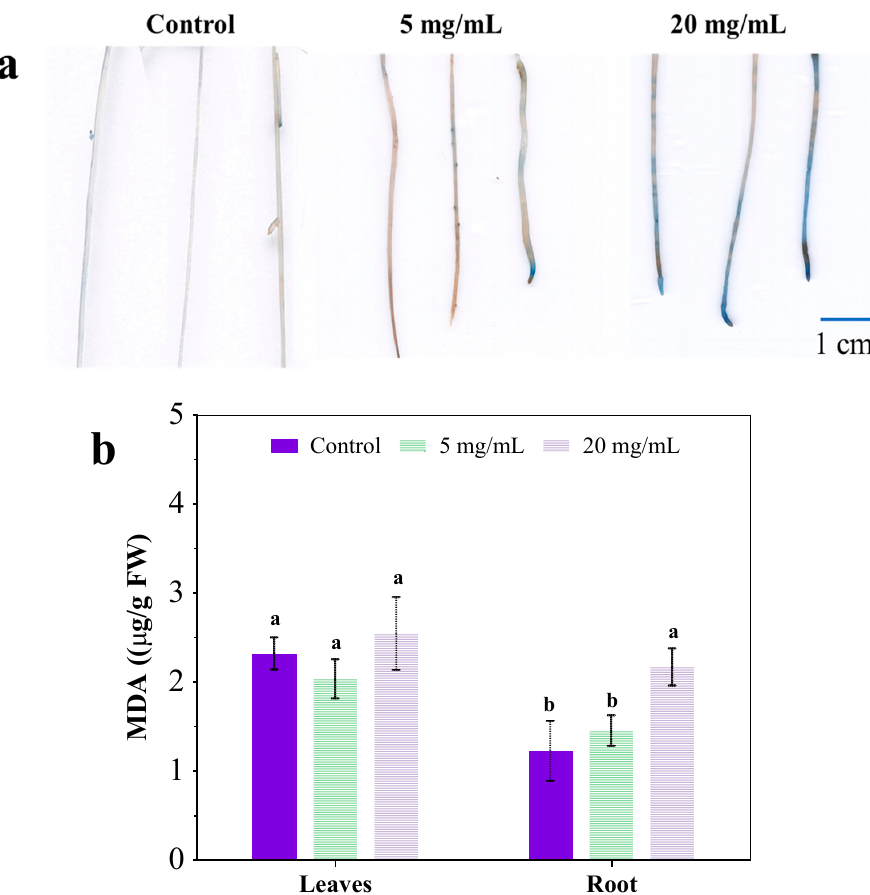
Figure 4. Root stained by Evan’s blue ( a ) and MDA content ( b ) after exposure to a C. camphora extract for 14 days. (The significant difference among different treatments is marked with different letters, p < 0.05.)